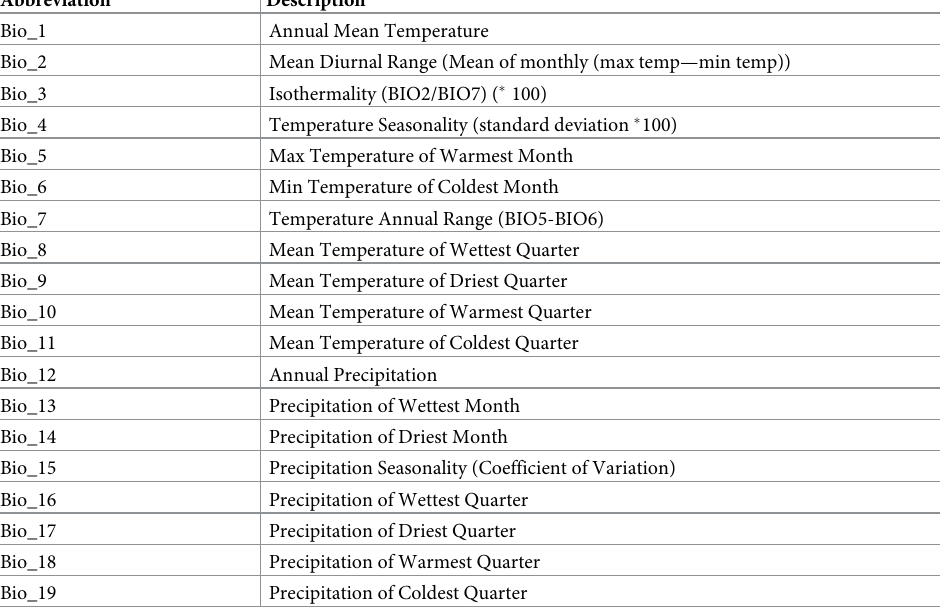
Table 1. Bioclimatic